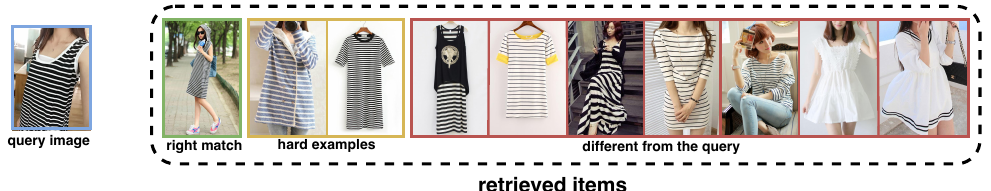
Figure 1. Example of consumer-to-shop clothes retrieval, which includes a query image (with a blue frame) and the 10 closest gallery images. The green frame represents the correct match, while the yellow examples represent hard examples, and the red frames represent items that differ from the query. As can be seen, the hard examples have many similarities with the query image. The slight superficial difference causes the images to be retrieved in the wrong way, which leads to system performance